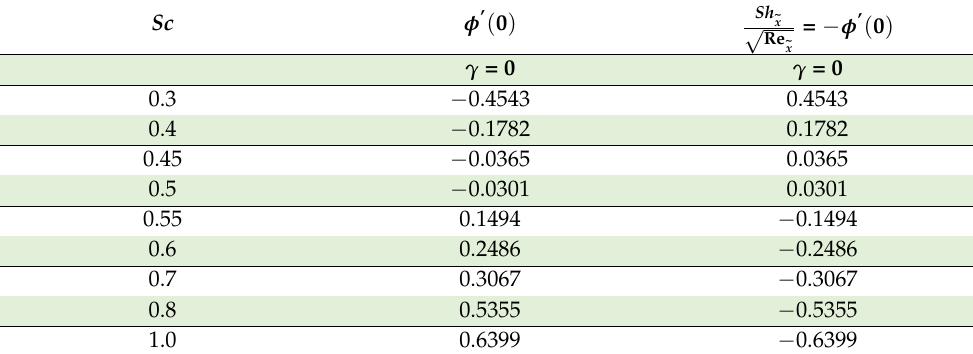
Table 10. Effect of Sc on Sherwood number for plate.